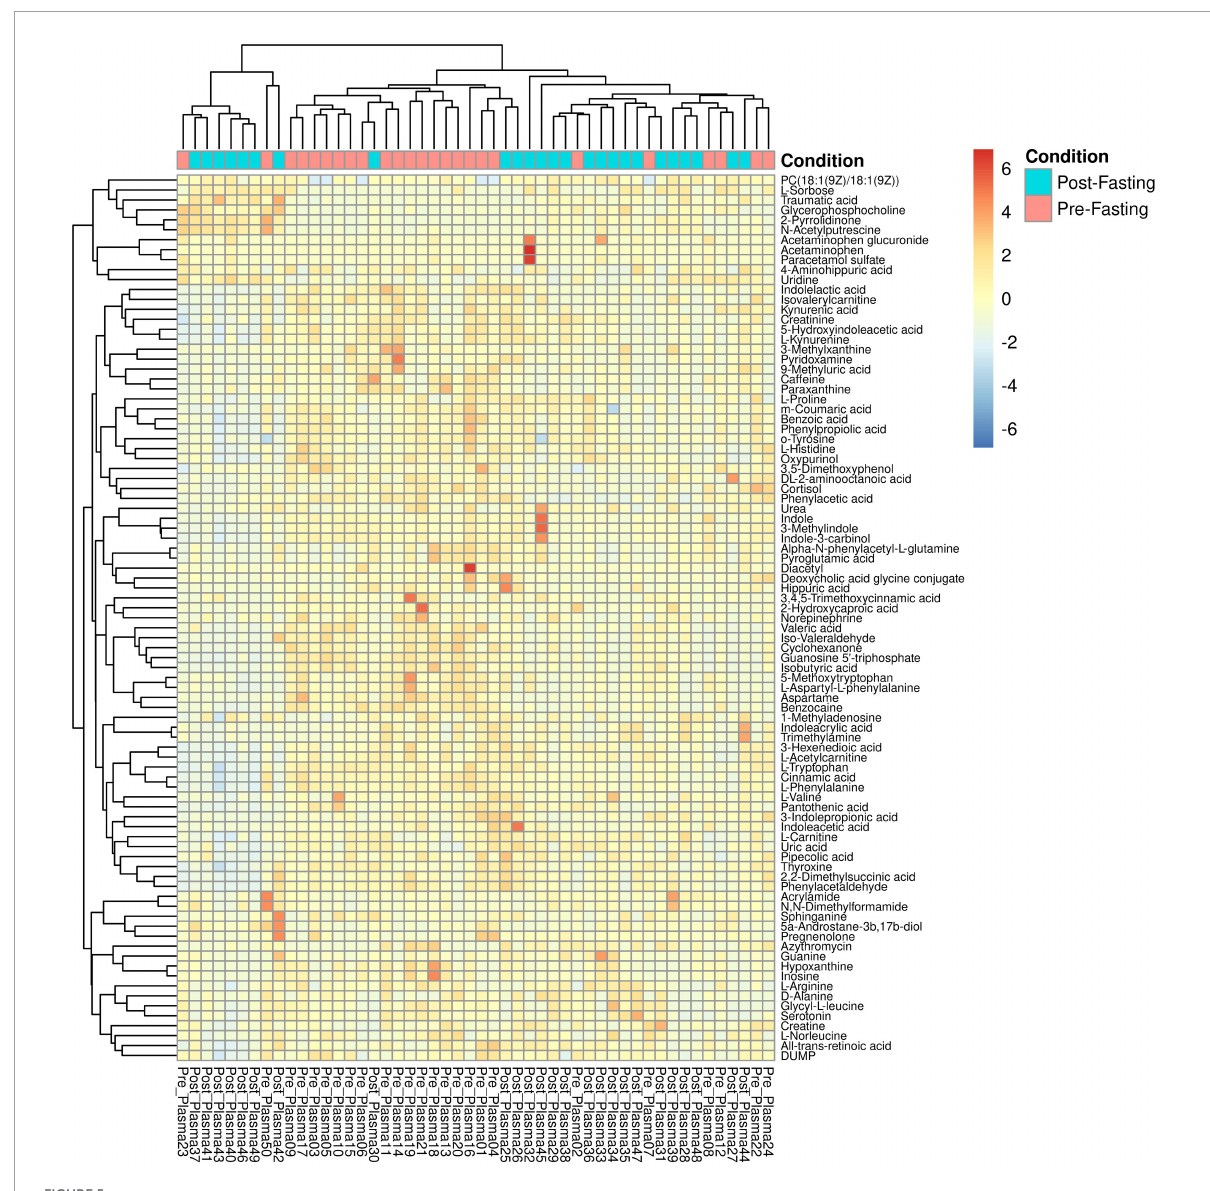
FIGURE5 Heatmap and hierarchical clustering of the 89 identified metabolites and 50 samples. Columns represent samples, rows represent metabolites, and the relative abundance of the metabolites is displayed by color. The sample time point as either pre- (red) or post-fasting (blue) is indicated by the top-most annotation